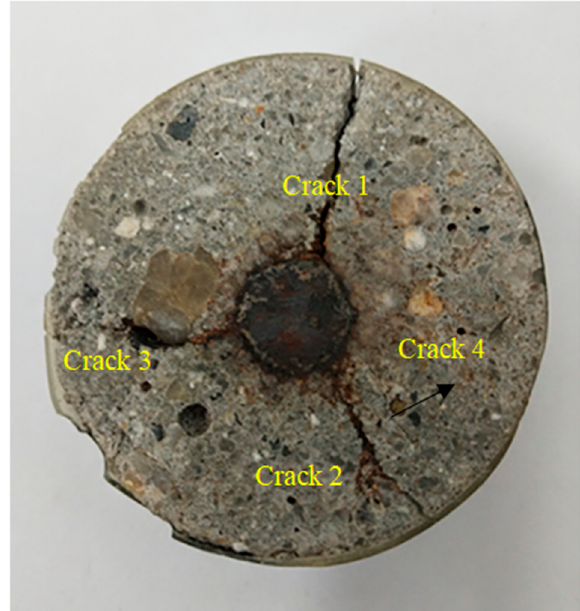
Figure 8. Reinforced concrete section.